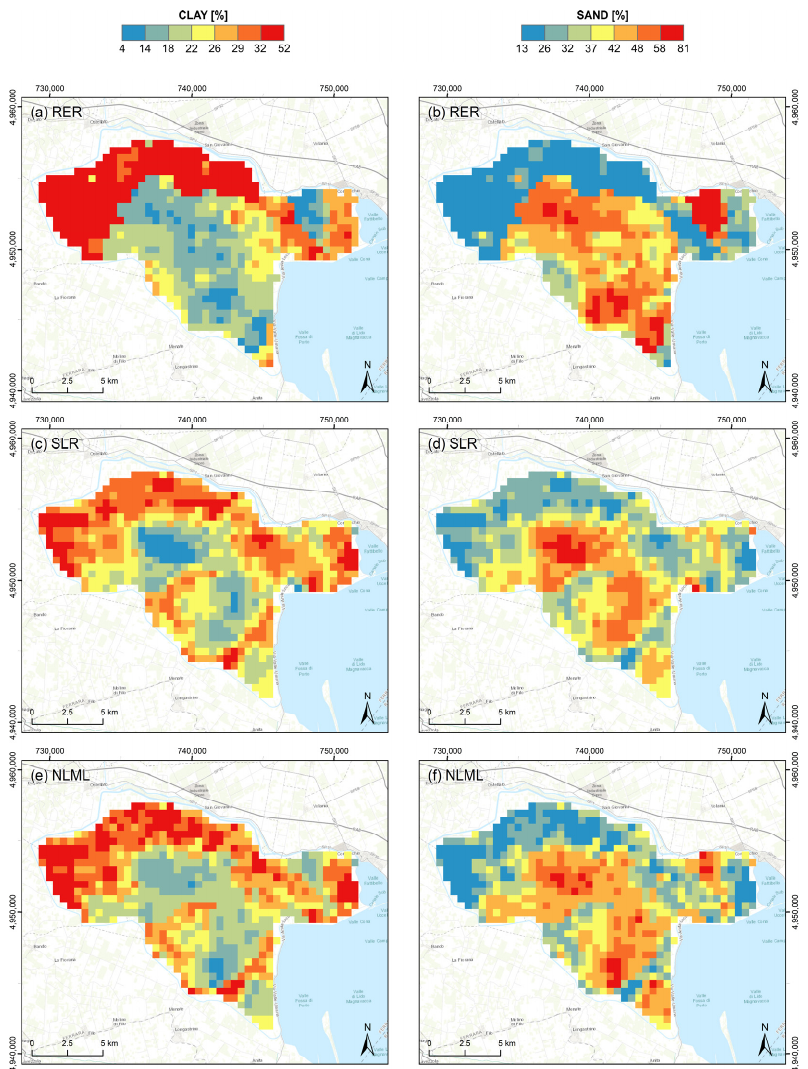
Figure 7. Clay maps provided by RER ( a ), predicted SLR models starting from K abundances ( c ), and by the NLML algorithm ( e ). Sand maps provided by RER ( b ), predicted by SLR models starting from K abundances ( d ) and by the NLML algorithm ( f ). Cartographic reference system: WGS 84, UTM Zone 32N.